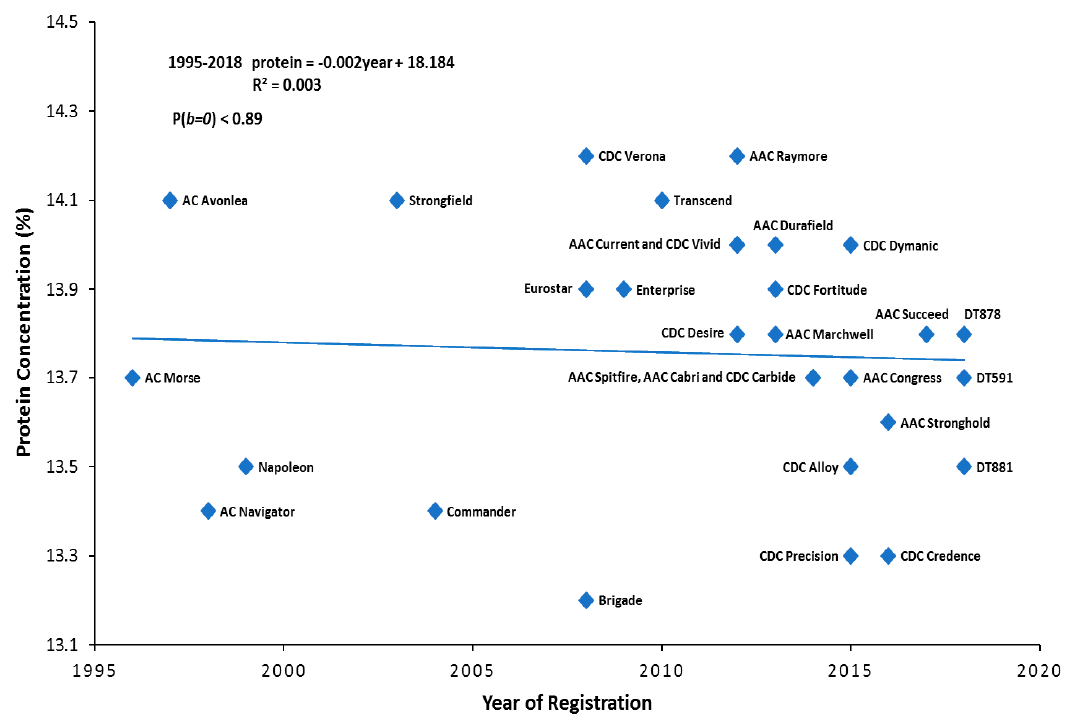
Figure 11. Grain protein concentration and year of registration of Canadian durum wheat cultivars. Data are analyzed using a similar method described by Clarke et al. (2010).